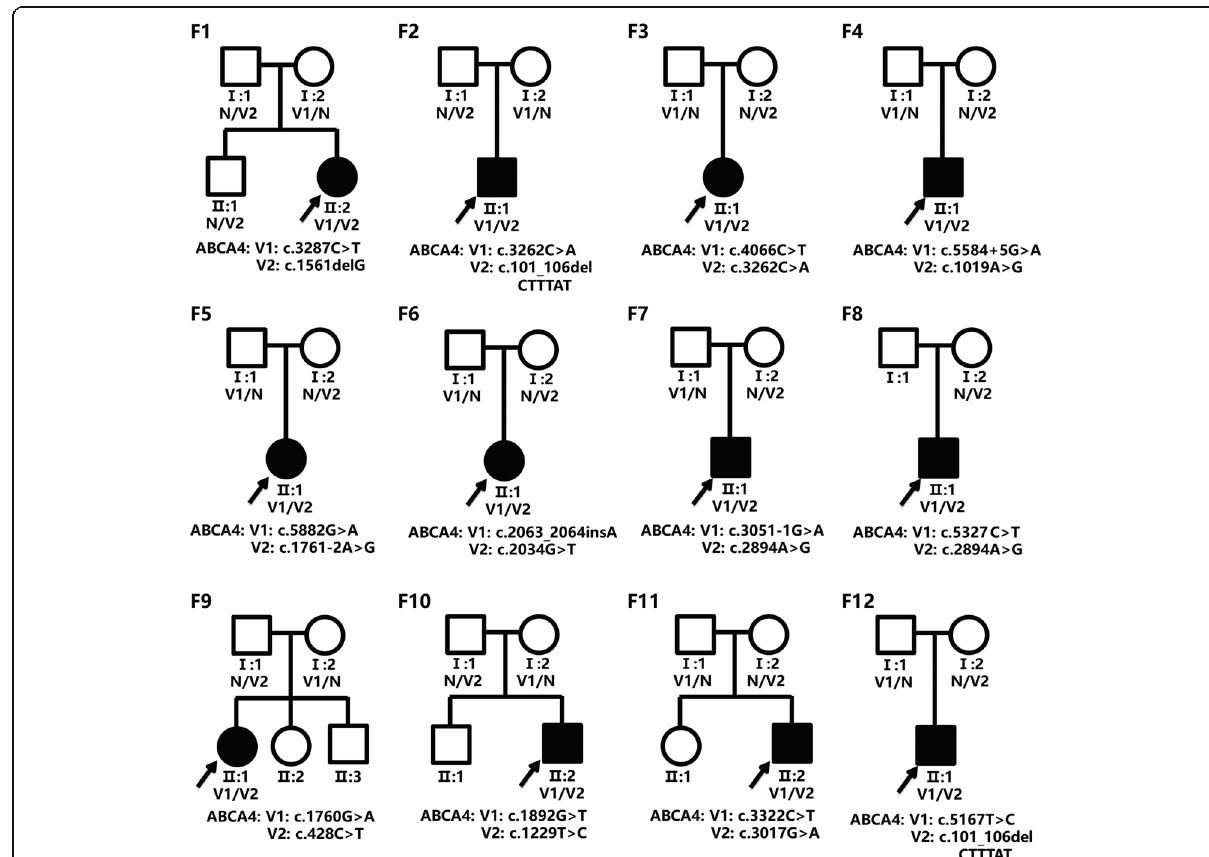
Fig. 1 Pedigrees of 12 Han Chinese families and identified mutants. Circles and squares indicate females and males, respectively. The darkened shapes indicate the affected members and the empty shapes indicate the subjects with normal phenotype. “ N ” represents a wild type allele and “ V ” represents a mutant